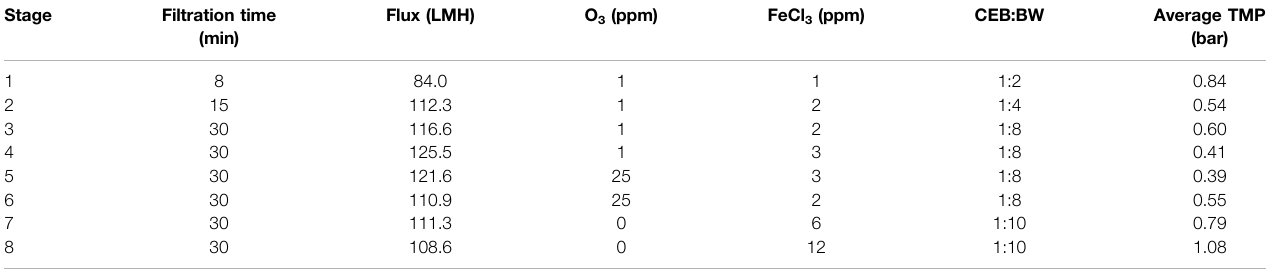
TABLE 3 | Summary of operational parameters set during the 8 operation stages of the ceramic MF membrane. Stage Filtration time